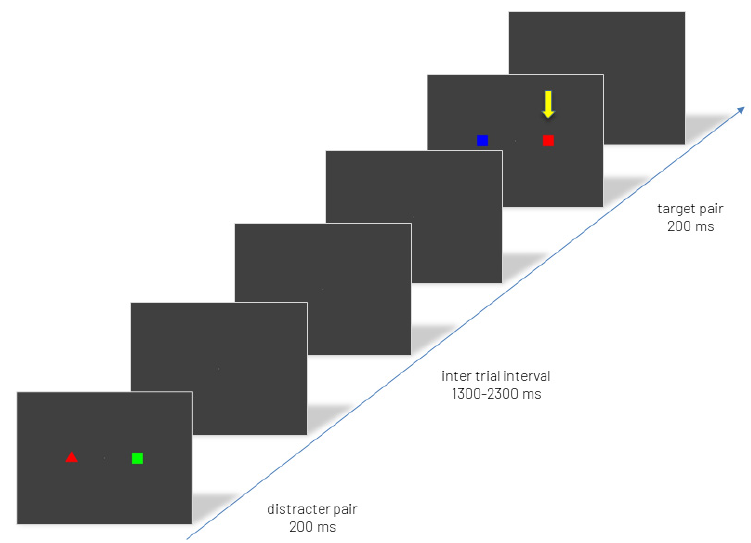
Figure 1. An outline of the cognitive task with two example trials separated by the inter-trial interval. In the actual experiment, 15 trials were presented during each 30 s block. The yellow arrow (not shown during the actual experiment) indicates the target stimulus. The relative size of the stimuli has been enlarged for illustrative purposes. Participants were instructed to respond with the left index finger to each instance of the distracter stimulus, and with the right index finger to each instance of the target stimulus.